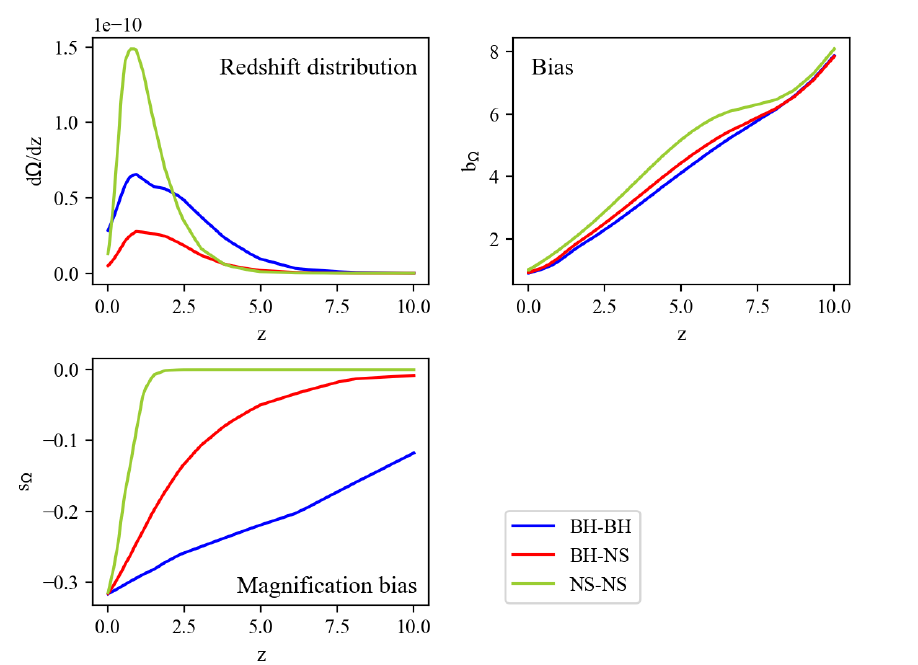
Figure A2. Redshift distribution, bias and magnification bias of the SGWB energy density, evaluated for BH-BH (blue), BH-NS (red) and NS-NS (green) for ET at 65